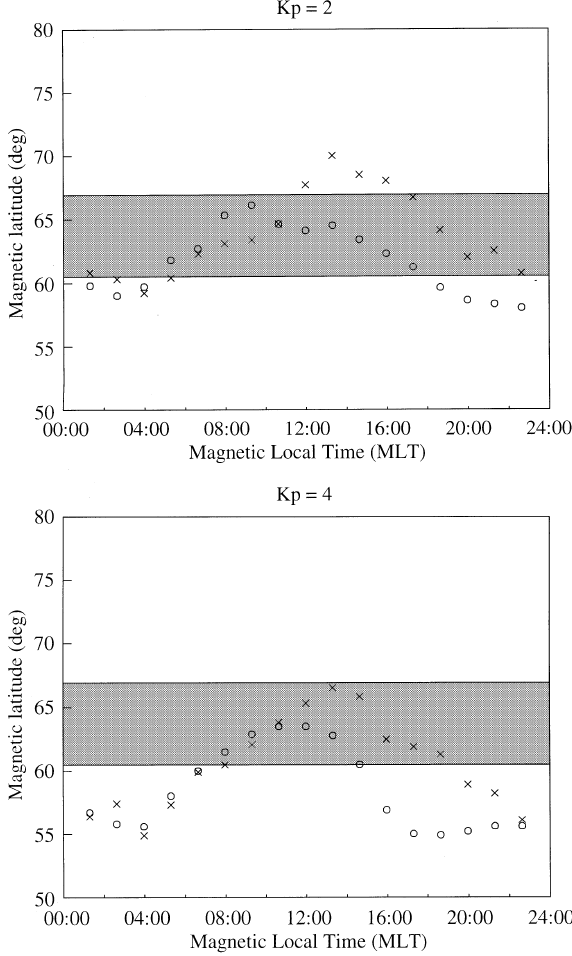
Fig. 6. The upper panel depicts the DMSP ion ( circles ) and electron ( crosses ) boundaries with respect to the SABRE field of view (illustrated by the shaded region ) determined for a K The lower panel depicts the boundary locations for a K The regions in which the ion and electron boundaries substantially separate (i.e. 1200 MLT to 2000 MLT) coincides with the MLT sector in which SARAS are